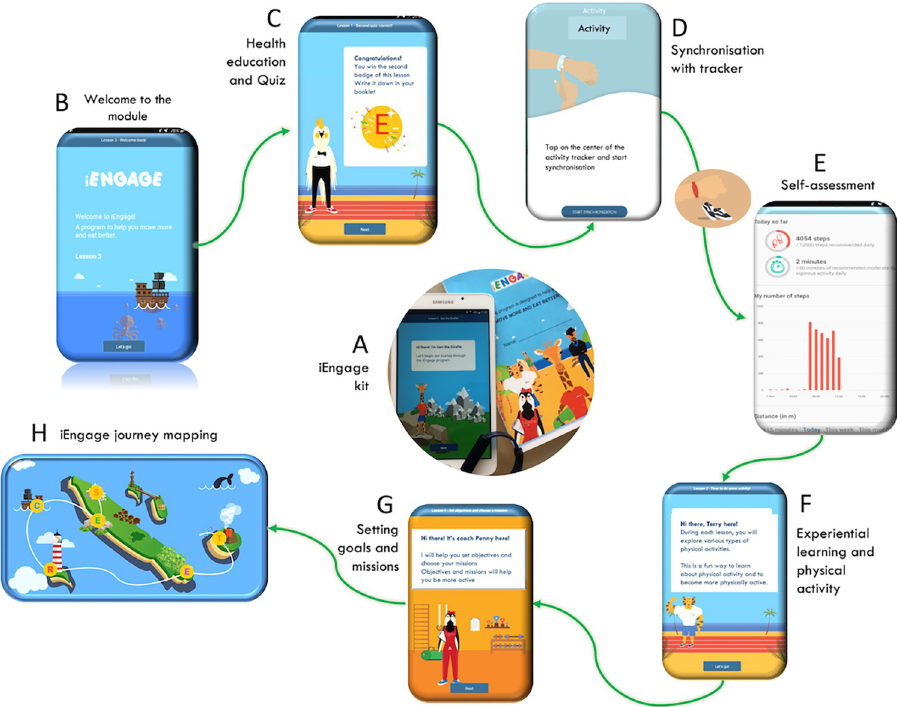
Fig 2. iEngage design. Design of the iEngage app interface and overview of the user experience. The iEngage kit including a tablet, a Misfit Ray activity tracker, earphones and a booklet (A). The digital environment supporting